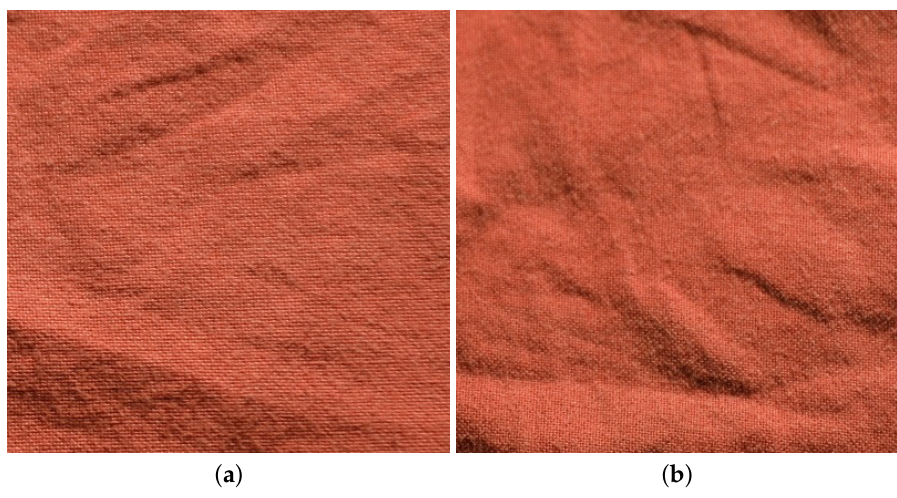
Figure 11. Images of a cotton sample from UJM-TIV: ( a ) when the viewing condition is frontal and lighting condition is at 20°. ( b ) with the same viewing and lighting conditions when the sample orientation is